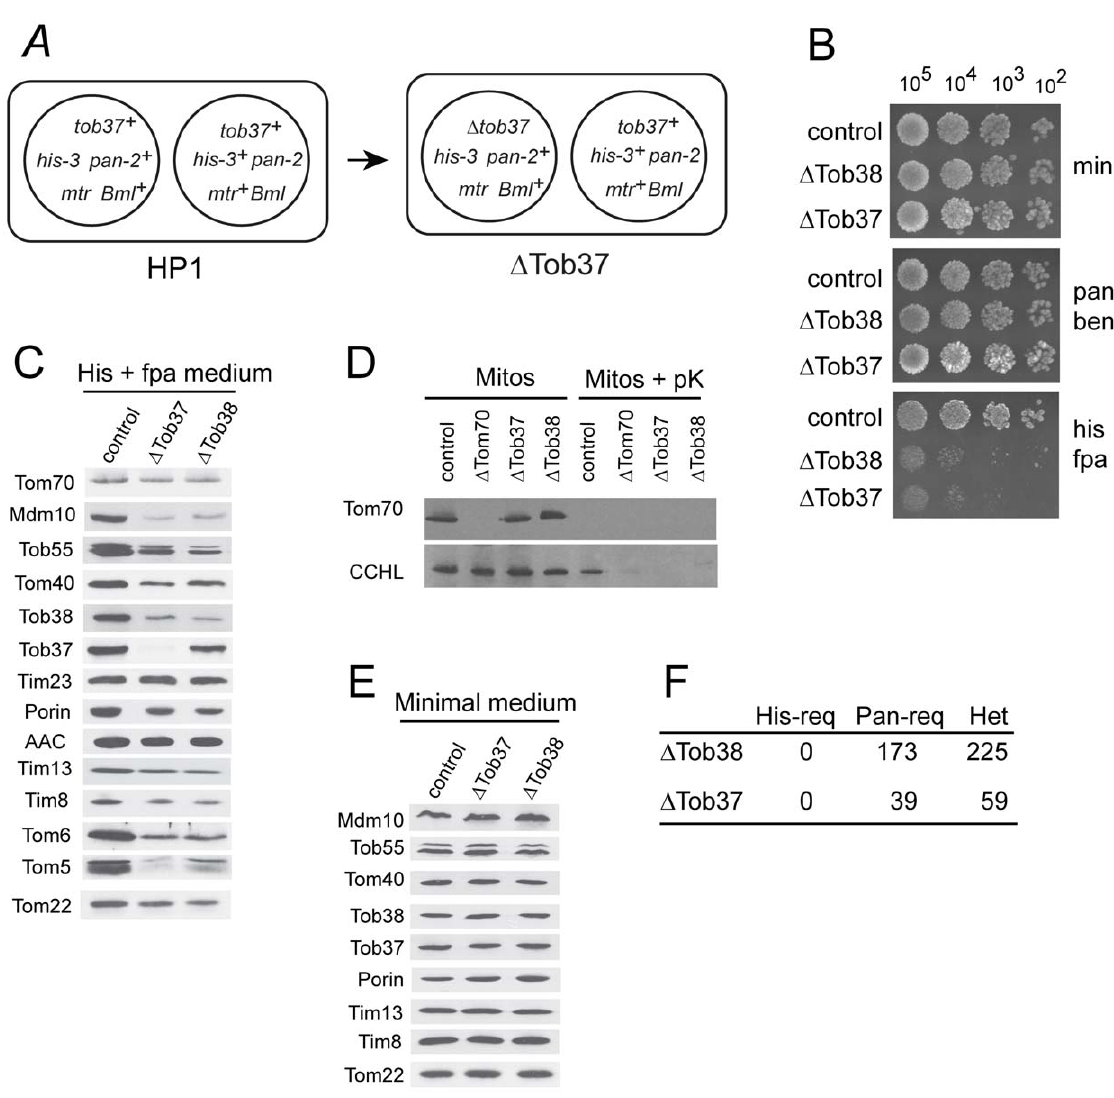
Figure 1. Isolation and characterization of N.crassa strains with reduced levels of Tob37 or Tob38. (a) Sheltered heterokaryons with deletions of either tob37 or tob38 in one nucleus of the heterokaryon were constructed using a split marker approach. Boxes symbolize heterokaryons while circles within the boxes represent the different component nuclei of the heterokaryon. The Figure shows an example for tob37 , but the process was identical for tob38 . The starting heterokaryon (HP1) contained nuclei with different genetic markers: either his-3 and mtr (provides resistance to fpa) or pan-2 and Bml (provides resistance to benomyl). Strains chosen for further work carried the knockouts in the his-3 mtr nucleus (see Methods). (b) Serial dilutions of conidiaspores (actual numbers spotted shown at top of panel) from the strains indicated on the left were spotted onto plates containing either minimal medium (min), which maintains both nuclei of the heterokaryon approximately equally; minimal medium containing pantothenate and benomyl (pan ben), which forces the nucleus carrying benomyl resistance ( Bml , Figure 1A) to predominate the culture; or minimal medium containing histidine plus fpa (his fpa), which forces the nucleus carrying fpa resistance ( mtr , Figure 1A) to predominate the culture. The control was strain HP1. (c) Cells from the indicated strains (top of panel) were grown in the presence of histidine (His) and fpa to force the predominance of the nucleus bearing the deletion of either tob37 or tob38 . This results in reduction of the levels of Tob37 or Tob38, respectively. Mitochondria were isolated and subjected to SDS-PAGE followed by transfer to nitrocellulose, and immunodecoration with the anitbodies indicated on the left. The control strain was HP1. Multiple bands in the Tob55 lane correspond to different isoforms of the protein [27]. (d) Mitochondria isolated from the indicated strains were either untreated (Mitos) or incubated in the presence of proteinase K (Mitos + pK) for 15 min. Mitochondrial proteins were then subjected to SDS-PAGE and western blotting. The blot was examined for the presence of Tom70 and the intermembrane space protein CCHL. (e) As in panel C, except strains were grown in minimal medium which maintains the numbers of both types of nuclei in the culture approximately equally. (f) Conidia produced from the sheltered heterokaryons ( D Tob37 and D Tob38) were streaked onto medium containing histidine and pantothenate. Individual colonies were isolated and tested for nutritional requirements to determine if they were histidine-requiring homokaryons (His-req), pantothenate requiring homokaryons (Pan-req), or heterokaryons (Het). doi:10.1371/journal.pone.0025650.g001 Tom40 precursor is imported across the outer membrane and can in the assembly of the b -barrel protein Tom40 (Figure 2B) was also then be detected associated with the TOB complex as interme- observed with both mutants. In wild type mitochondria the diate I of 250 kDa. The precursor is then integrated into the